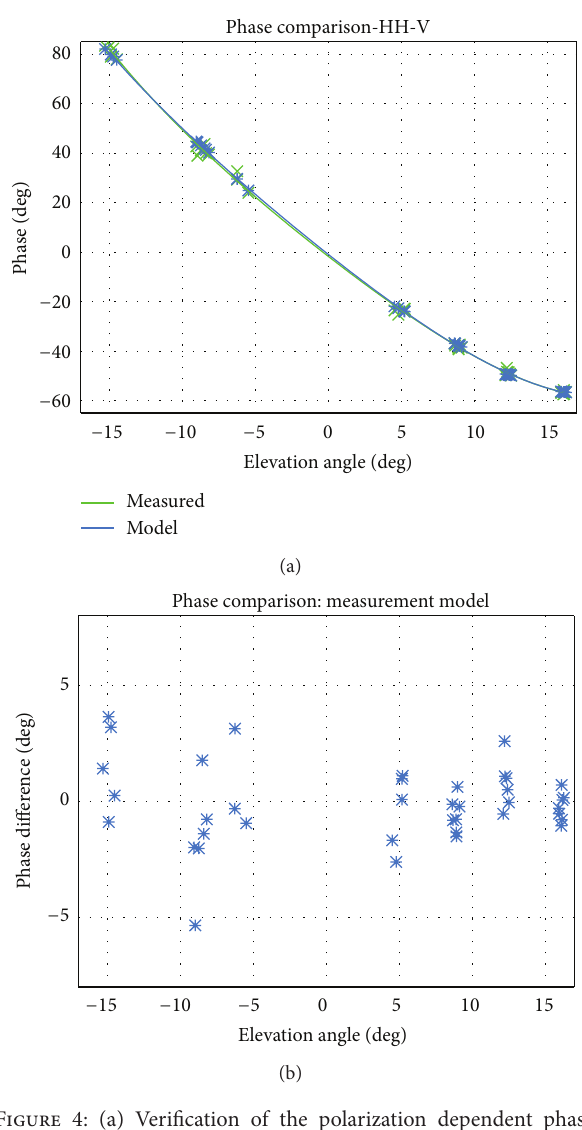
Figure 4: (a) Verification of the polarization dependent phase deviation: Measurements versus Antenna Model, (b) Deviation between HH-VV of the model and the